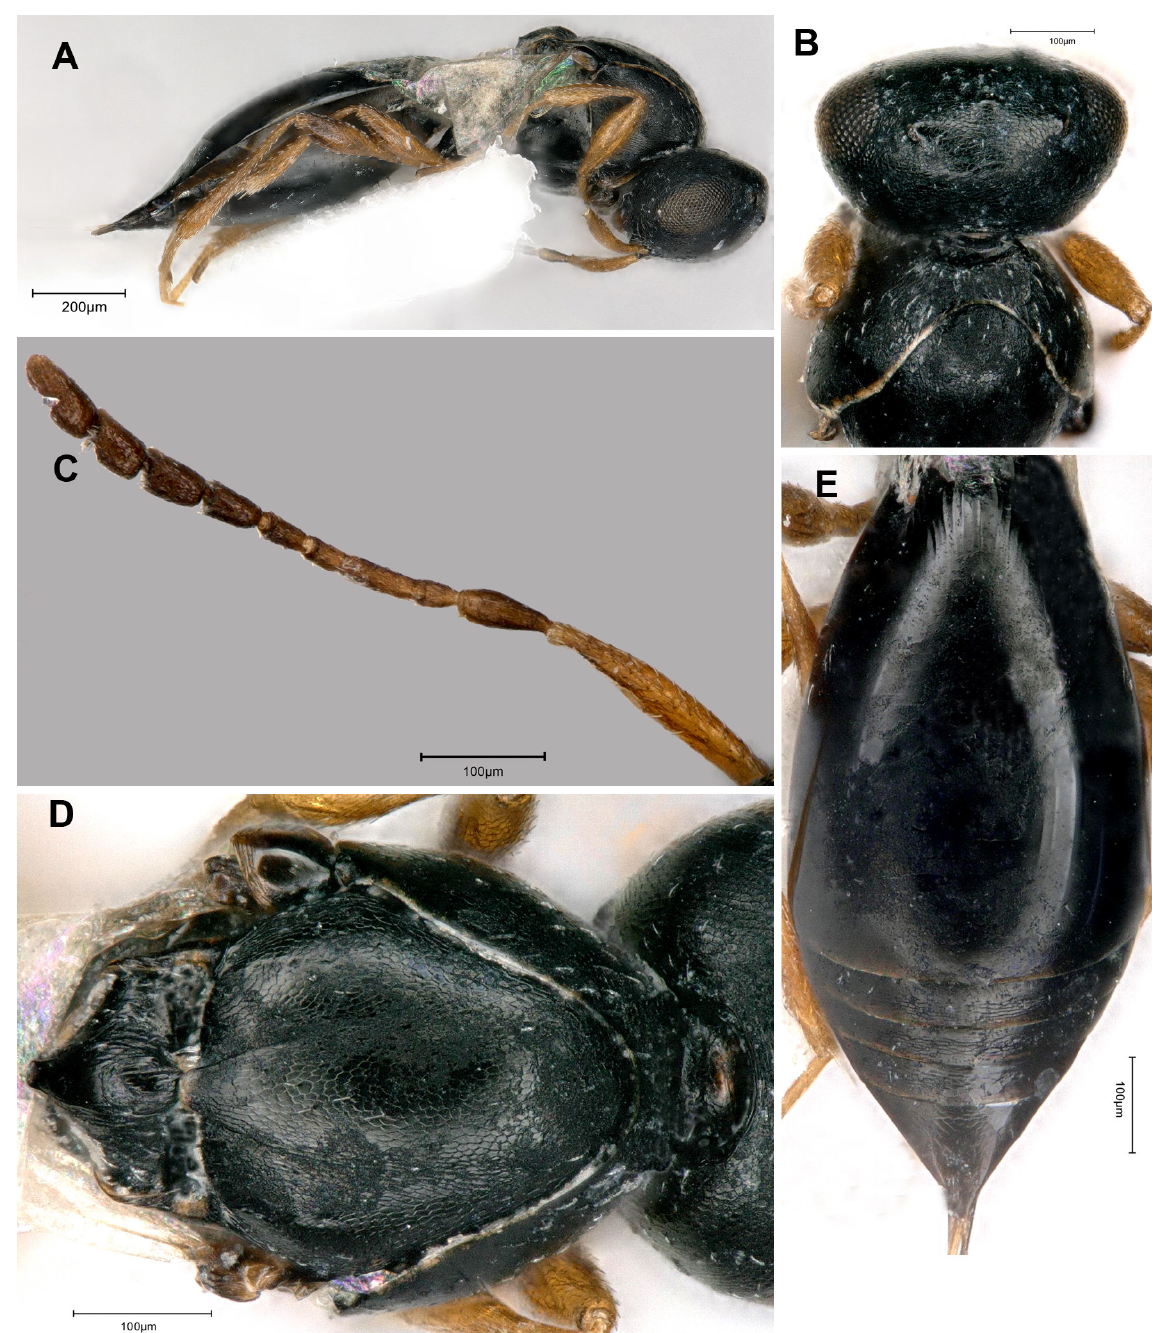
Fig. 4. Synopeas calecai Buhl & Asadi sp. nov., holotype, ♀ (HMIM). A . Habitus in lateral view. B . Head and pronotum in dorsal view. C . Antenna. D . Mesonotum in dorsal view. E . Metasoma in dorsal view. Scale bars: A =200 µm; B–E = 100